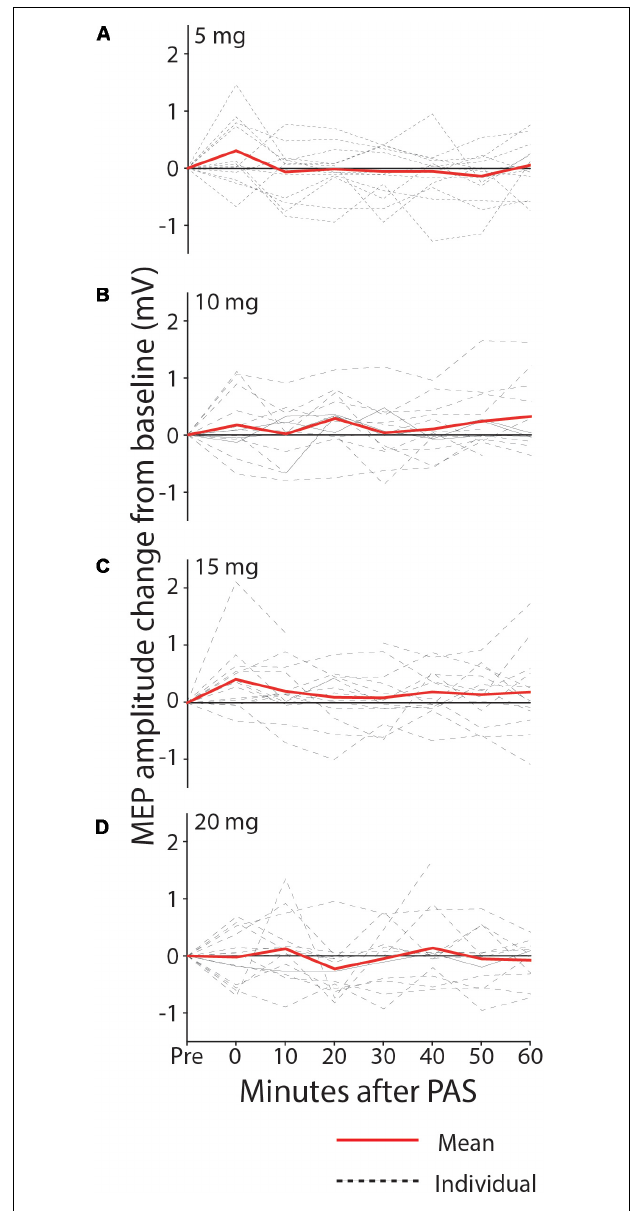
FIGURE 4 | MEP change from baseline after PAS with 5 mg (A) , 10 mg (B) , 15 mg (C) , and 20 mg (D) memantine. Group MEP amplitude over the 60 min following PAS was not significantly increased from baseline, with any dose of